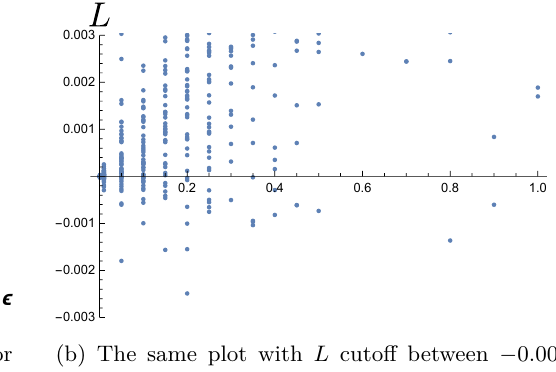
and 0 . 003 to emphasize the negative values.